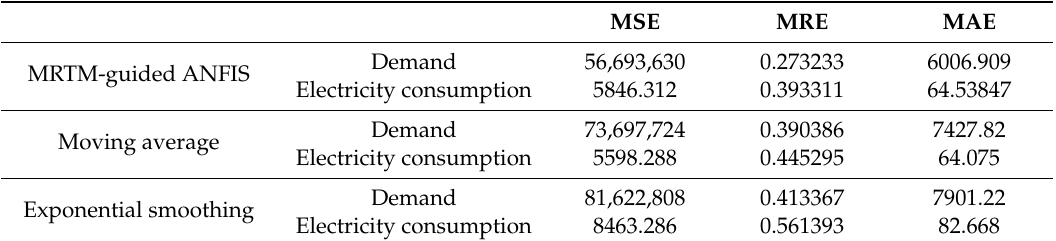
Table 6. Comparative analysis between MRTM-guided ANFIS and time-series forecasting methods. MSE MRE